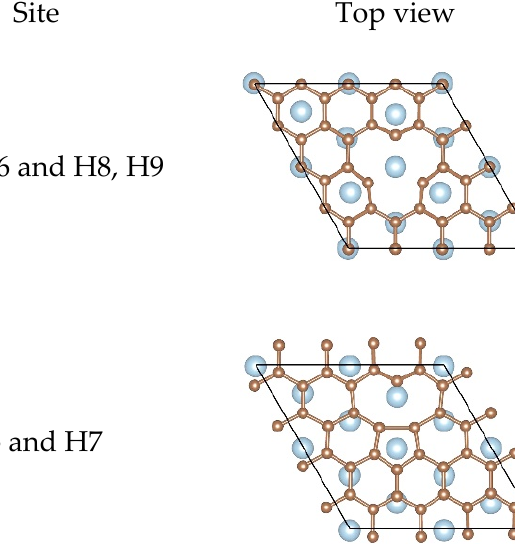
Figure 3. Top views and side views of the SW defect graphene on the Al (111) surface after the structural optimization.